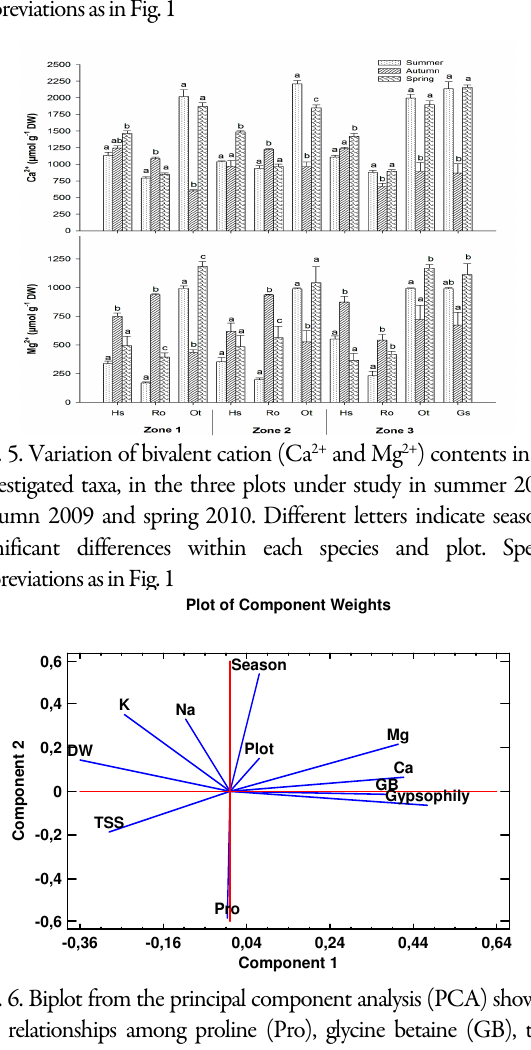
Fig. 3. Variation of glycine betaine (GB) and total soluble sugars (TSS) contents in the investigated taxa, in the three plots under study in summer 2009, autumn 2009 and spring 2010. Different letters indicate seasonal significant differences within each species and plot